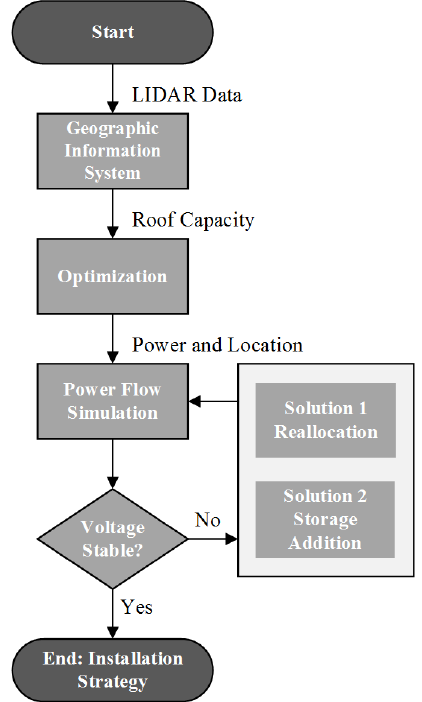
Figure 2. Example of a GIS-based energy system modeling workflow for identifying the optimal sites of photovoltaic plants (adapted from